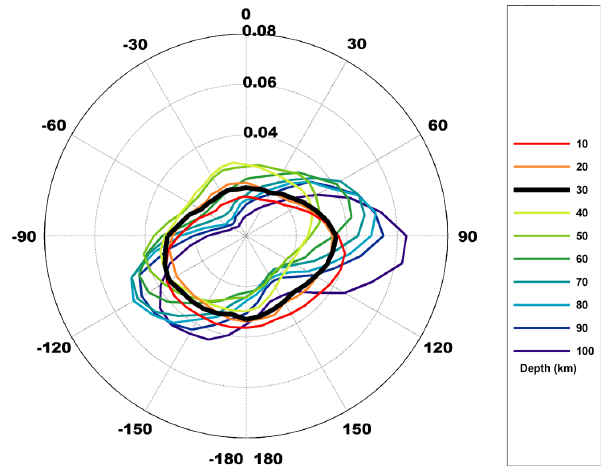
Fig. 3. The background azimuth distribution of A p ( D ep , where D ep ranges from 5 to 100km). The black line denotes D ep of 30km re- vealing a discontinuous boundary of background azimuth distribu-